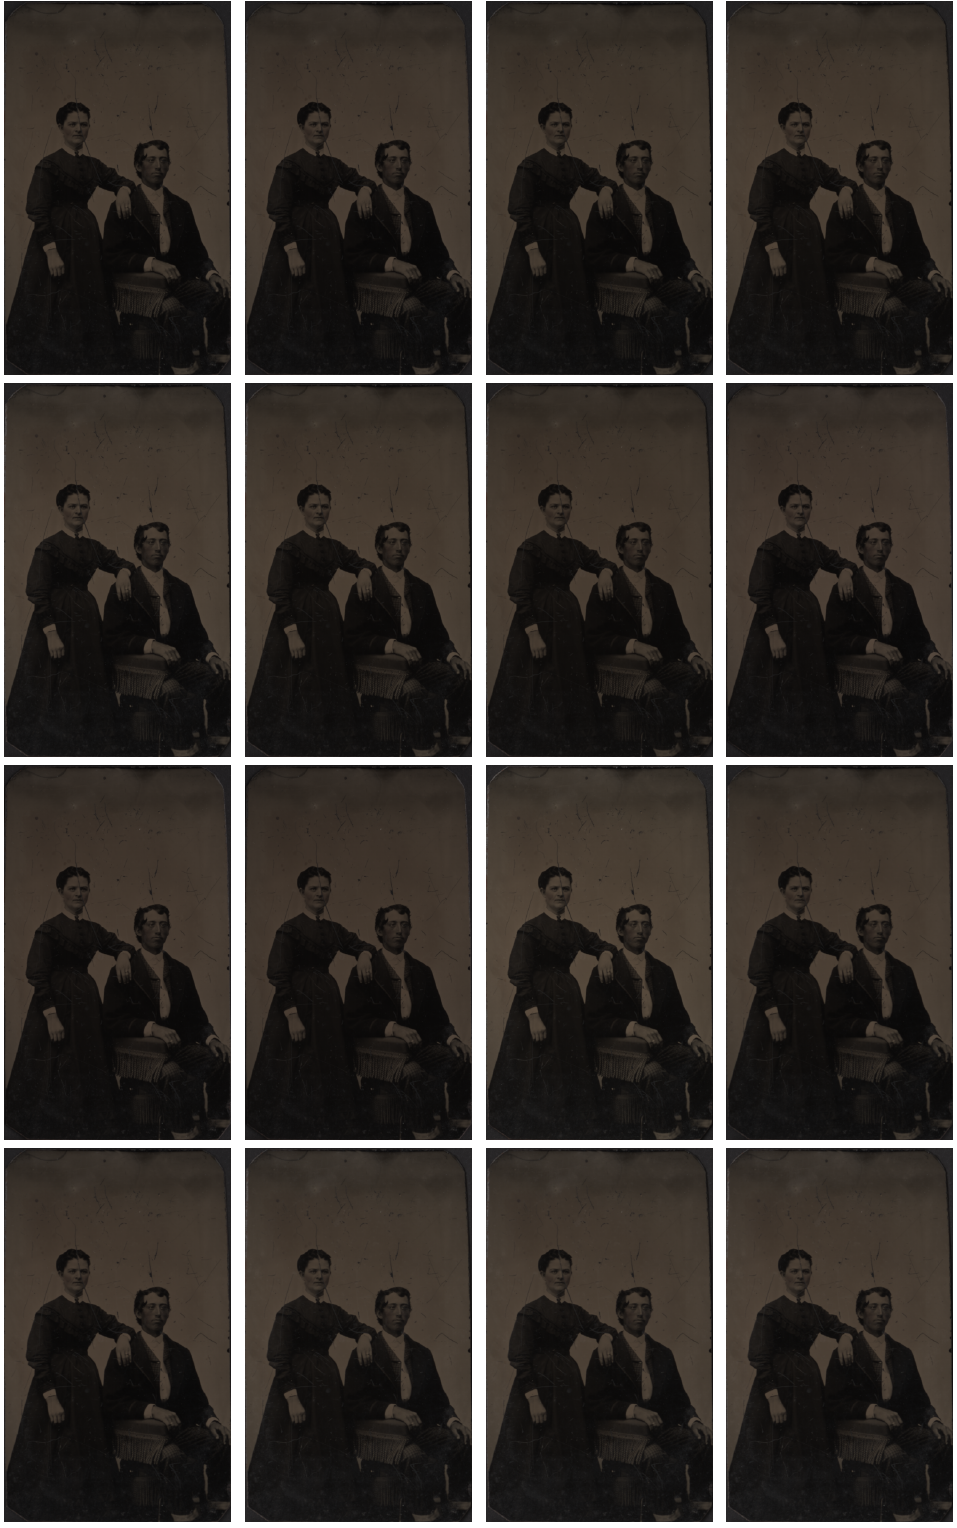
Figure A3. Images of tintypes scanned with different light modes. From left to right: LRFB , LR , LFB